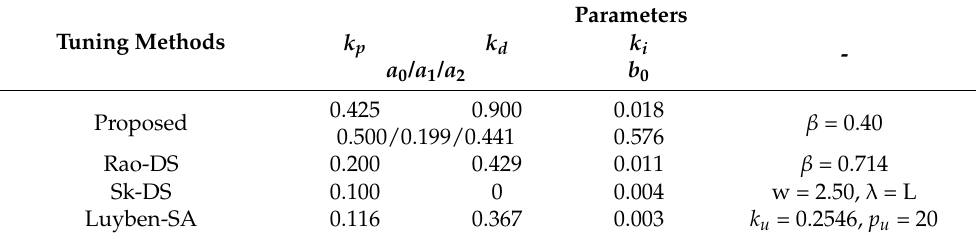
Table 1. Controller tuning for PIPTD.